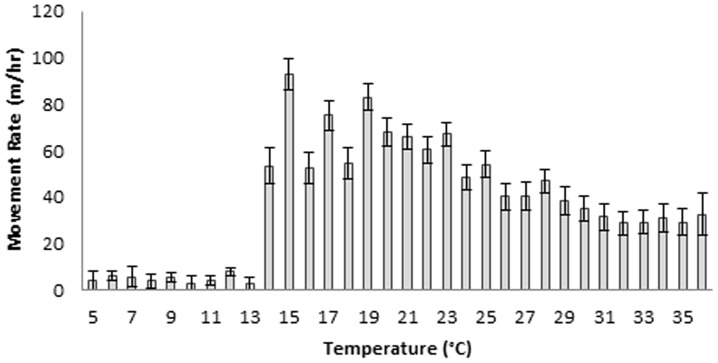
Mean movement rates (m/hr) per 1° change in temperature by bobcats at Bull Neck Swamp Research Forest, North Carolina, March 2008–October 2009.Temperature was averaged using the temperature at start and end points used to calculate mean movement rates. Capped lines represent standard error bars.